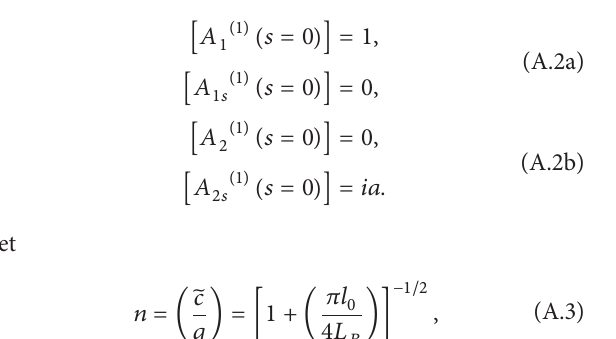
Table 1: PCF versus 𝑧 plots.